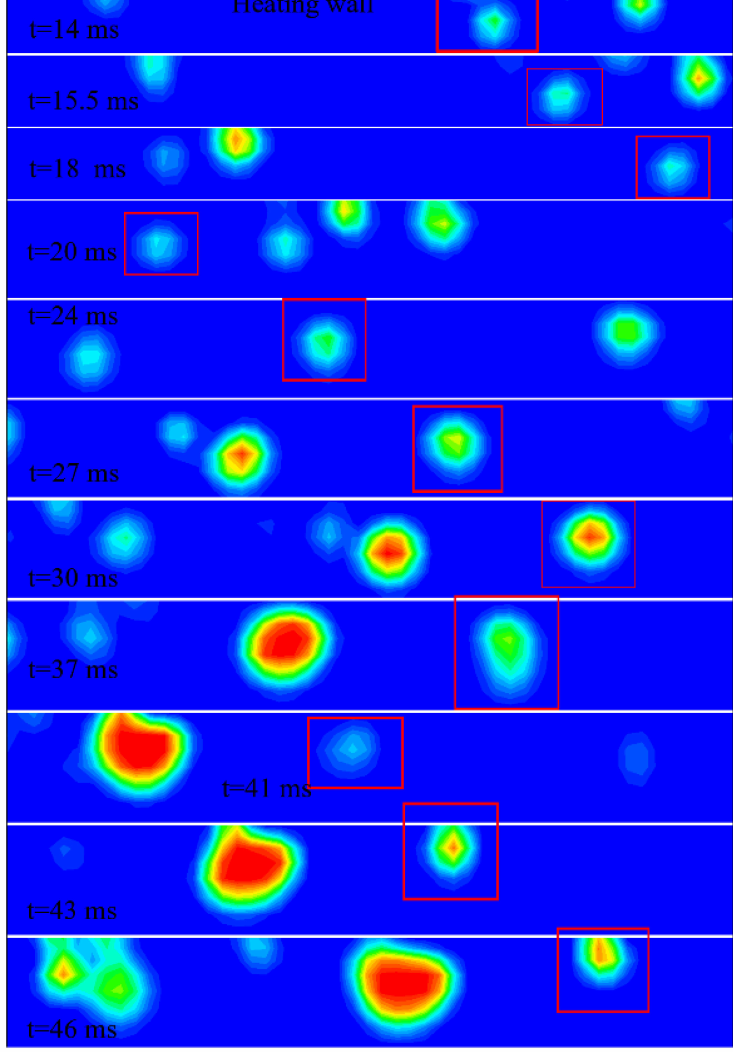
Figure 9. The developing process of a bouncing bubble with